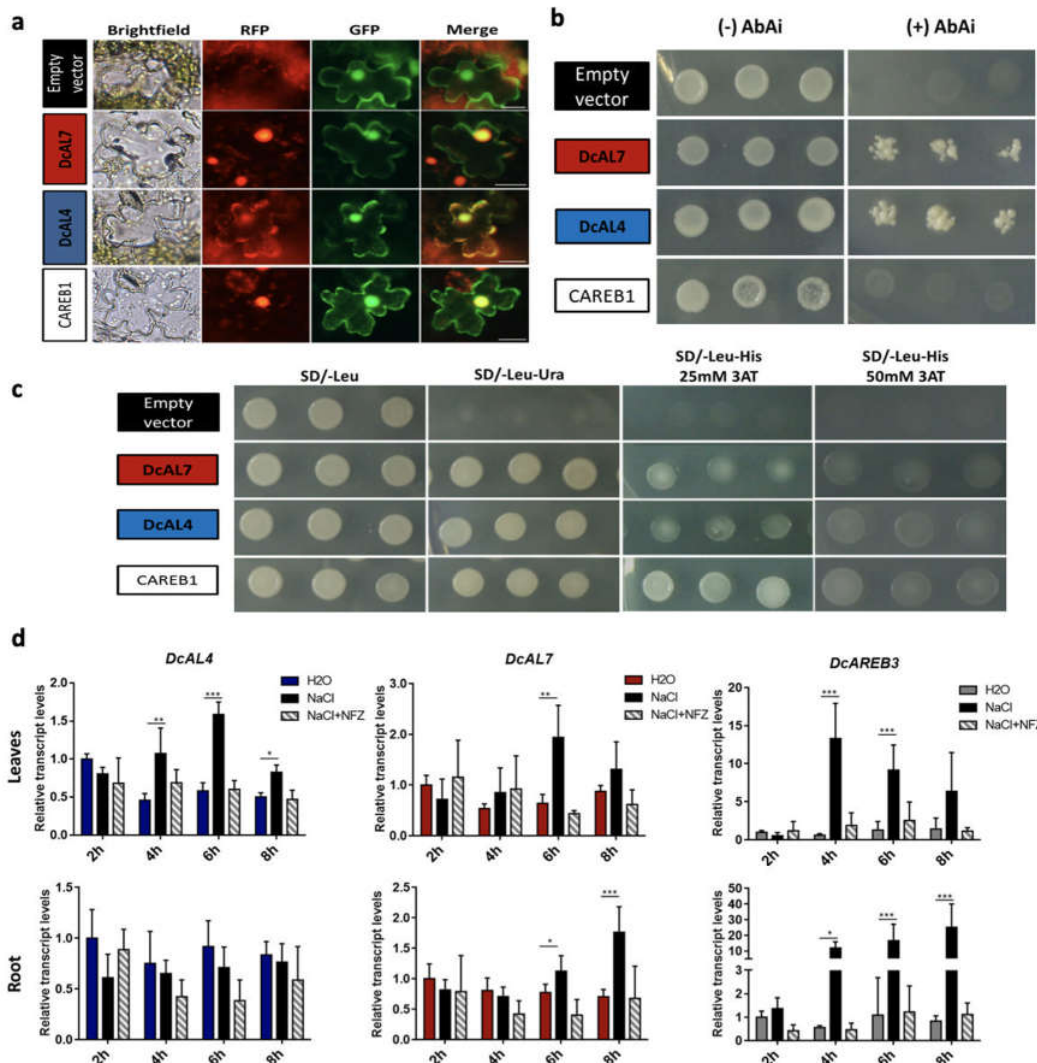
Figure 2. Functional characterization of DcAL4 and DcAL7 . ( a ) Subcellular localization of DcAL4 and DcAL7. Co-infiltration of tobacco leaves with Agrobacterium carrying the DcAL4:RFP and DcAL7:RFP plasmids, 35S:GFP (cytoplasmic and nuclear marker) or DcCAREB1:RFP (nuclear local- ization positive control; GenBank: EU433292.1) vectors. RFP red channel: Images taken using the Cy3 filter. GFP Green channel: Images taken using the FITC filter. Bar: 25 μM. ( b ) Monohybrid assay to determine the DNA binding capability of DcAL4 and DcAL7 transcription factors to the DcPSY2 promoter. The strains were grown on SD/-Ura-Trp medium supplemented with or without Auro- basidin A (AbAi). ( c ) Transactivation assay using DcAL4 and DcAL7 transcription factors to induce the expression of the reporter genes URA3 and HIS3 in the reporter yeast strain grown on SD (SD/- Leu medium, SD baseline without leucine), SD/-Ura (auxotrophy for uracil), SD/-His + 25 mM and 50 mM 3AT (auxotrophy for histidine). ( d ) DcAL4 and DcAL7 relative transcript levels in D. carota leaves and roots under acute salt (250 mM NaCl) and ABA synthesis inhibitor (norflurazon, NaCl- inh) treatments. DcAREB3 transcript levels were used as treatment control gene. Transcript abun- dance was normalized to DcUbiquitin transcript levels and the H 2 O − 2 h control condition was used as calibrator. All values represent the means of three independent replicates (+SD). Statistically sig- nificant differences were determined by two-tailed ANOVA test: * p < 0.05, ** p < 0.01, *** p < 0.001. Considering that 11 ALFIN responsive elements were found in 750 bp of the DcPSY2 promoter (Figure 1A) and that in carrot the transcript levels of DcPSY2 are induced under